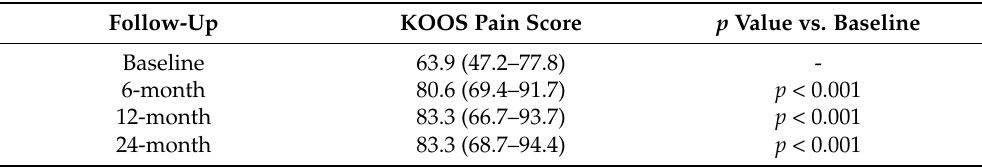
Table 2. KOOS pain score at different time